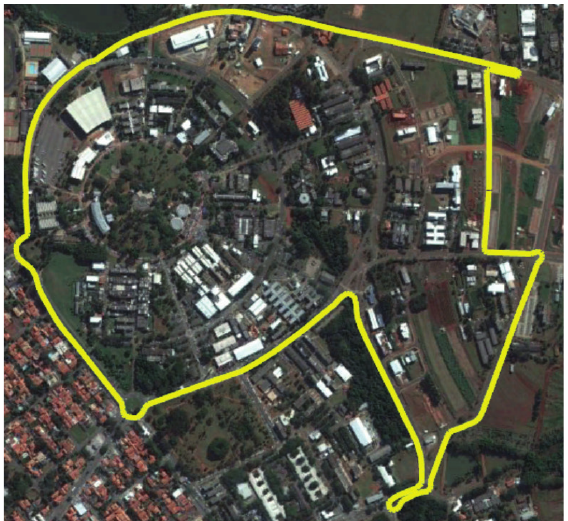
Figure 4. Route performed for the